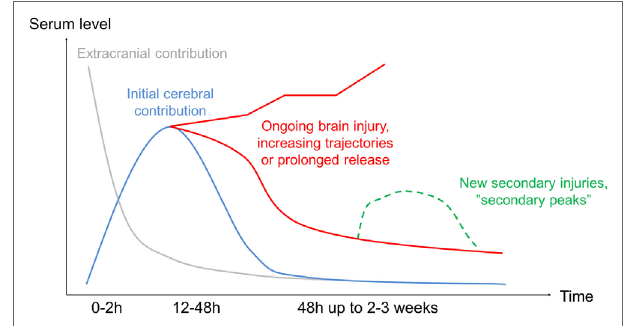
FigURe 3 | Protein kinetics following injury. Highlighting the estimated temporal profile from trauma if frequently sampled. Initially, there will be a major release of the protein from extracranial sources (gray line), in theory more so if it is present to a larger extent in tissue likely to be injured (i.e., S100B in adipose tissue), even if this contribution generally decreases rapidly. The cerebral contribution (blue line) will continue to increase in serum (for S100B up to 27 h), presumably due to influx from the injured brain. In case of ongoing injury development, the subsequent serum samples may have a prolonged decline or even continue to increase depending on the injury severity (red line). In case of a new injury development, secondary peaks have been shown (green line). While this pattern is most studied for S100B, it applies to some extent to all the biomarkers even if the time frames are